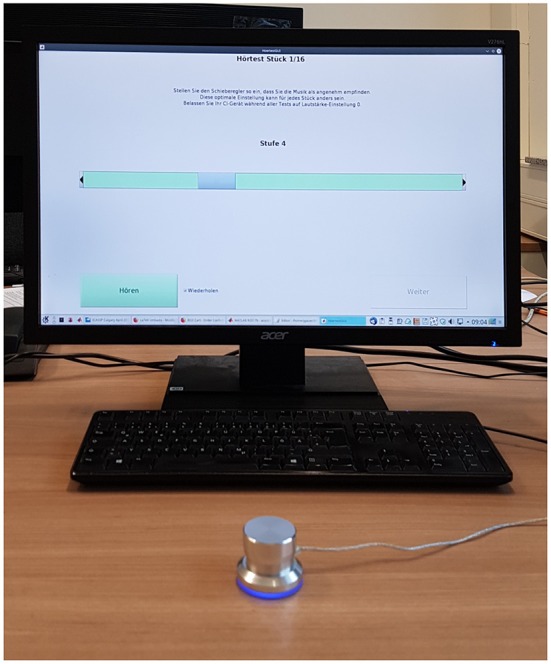
Interactive user interface used in the listening experiments. The participants used the jog-dial in front to select the complexity reduction levels in real-time while the stimuli were presented in an infinite loop. The blue slider on the green bar indicates the currently active level.